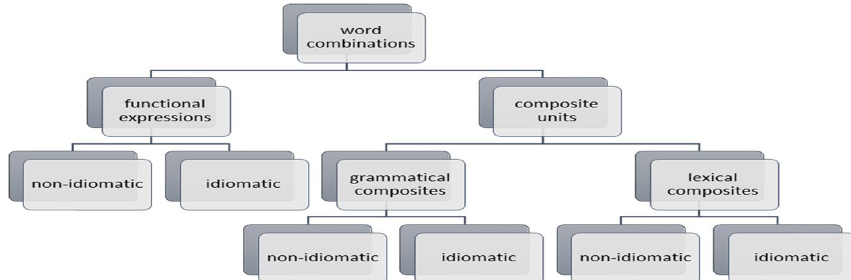
Fig. 1 Howarth’s (1998a) phraseological